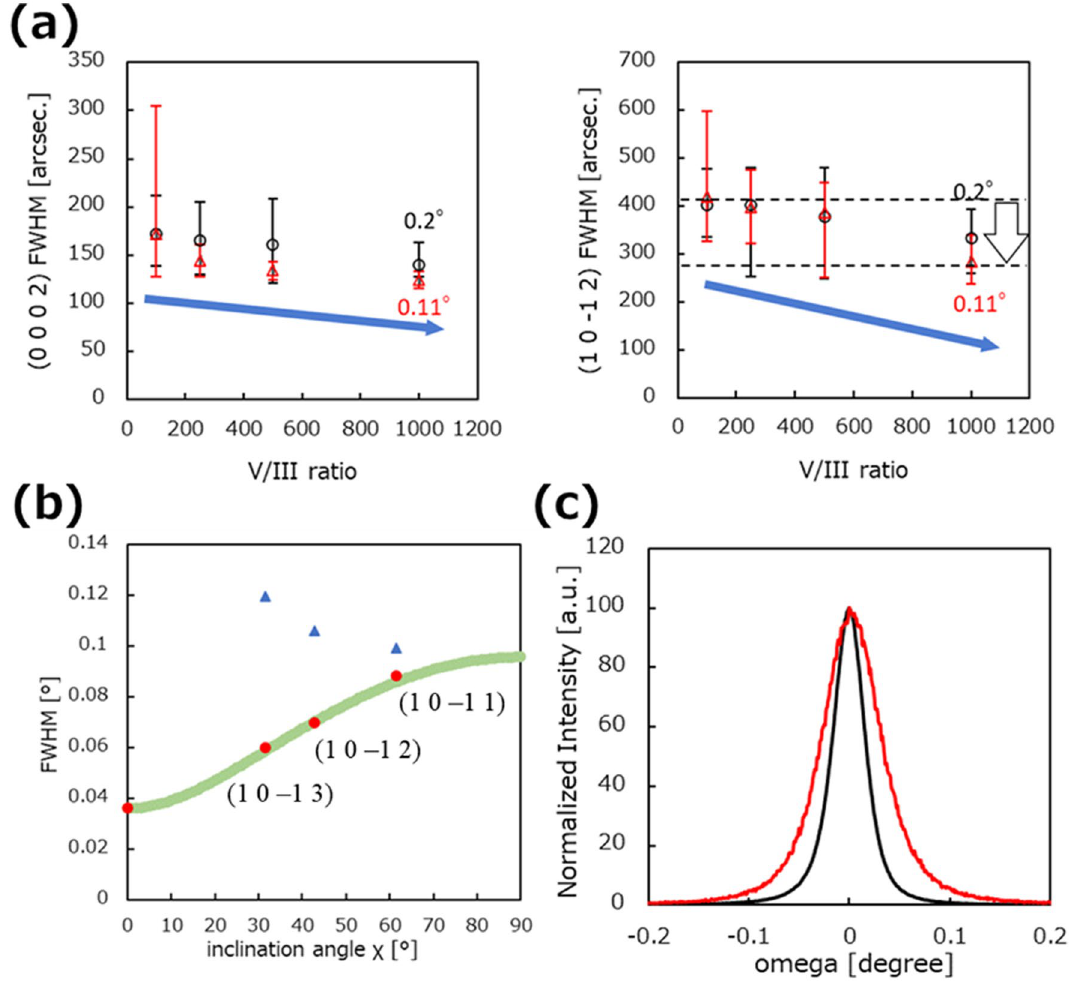
Figure 4. FWHM of XRC measurements obtained for crystalline orientation after second AlN layer growth. ( a ) FWHM of (0002) (left) and (10–12) (right) as a function of V/III ratio dependency for AlN grown on 0.2° and 0.11° miscut-angle sapphire substrate. ( b ) FWHM of XRC φ (blue triangle) and ω (red circle) scans at various inclination angles ( χ s). The green theoretical curve was fitted using Eq. (1) according to Refs. 24 and 25 using the FWHM of the ω scan. ( c ) XRC FWHM spectrum 20 mm from the center of a layer grown on sapphire with a miscut angle of 0.11° and V/III ratio of 1000. The black line indicates the (0002) plane, and the red line indicates the (10–12)